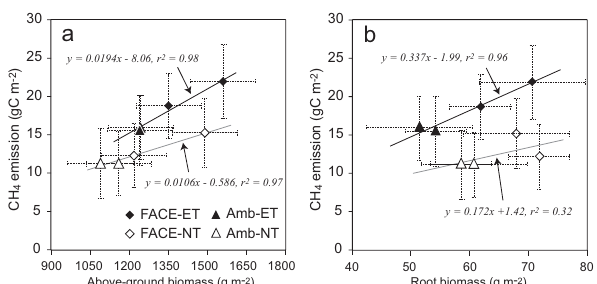
Fig. 5. Seasonal total CH 4 emission (adjusted for Fe reduction) plotted against above-ground biomass (a) and root biomass (b) . Bars indicate 90% confidence intervals. Each point corresponds to a certain treatment plot (e.g., FACE-ET) in either 2007 or 2008.